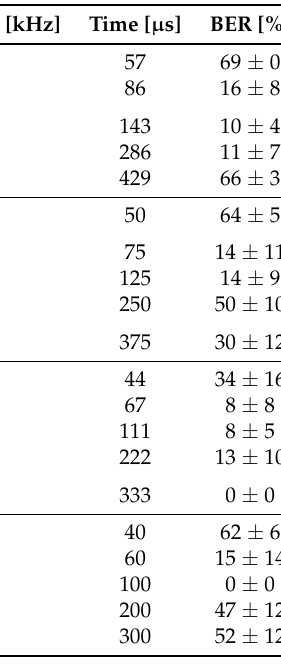
Table 2. BER of the PSK for modulation for a set of measured